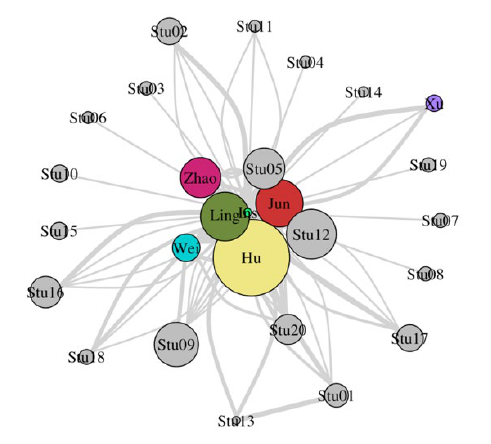
Figure 4. The overall social-cognitive network. Node color represents the six participatory roles (i.e., leader in green, starter in red, influencer in yellow, mediator in blue, regular in pink, and peripheral in purple). Node size represents the weighted IKI score, and edge width represents the weighted GKC score. Learners who did not participate in this research are marked as grey nodes; edge directions were deleted for network